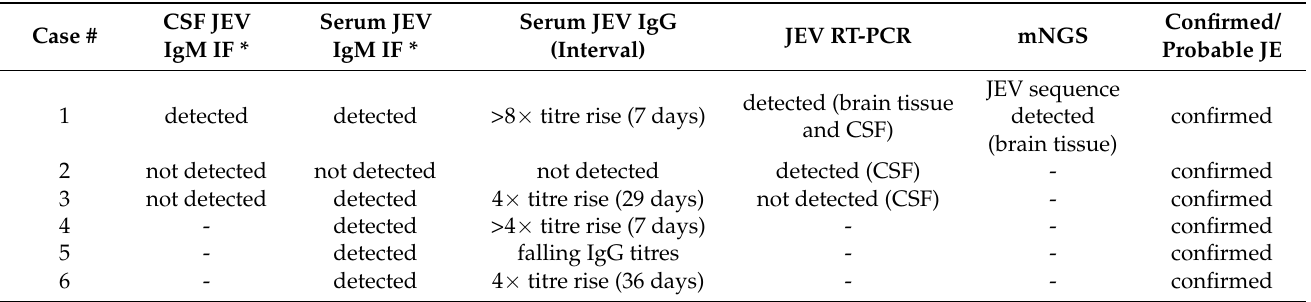
Table 3. Diagnostic results for the twelve confirmed cases of Japanese encephalitis from New